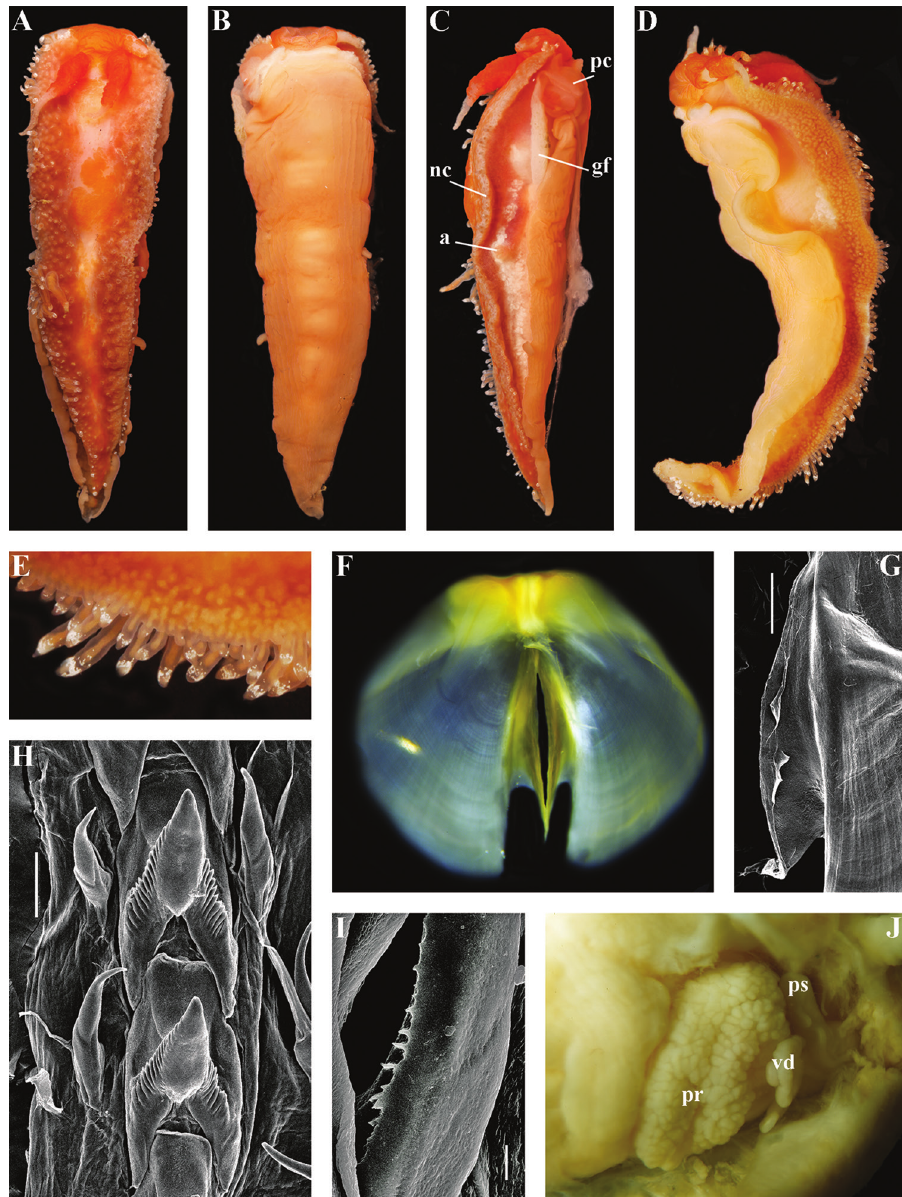
Figure 3. Chlamylla borealis borealis Bergh, 1899, stat.n. ZMMU Op-479. Kara Sea, living animal 46 mm in length: A dorsal view B ventral view C right lateral view D left lateral view E details of cerata and notal edge F jaws, frontal view, light microscopy G details of masticatory process of jaw, SEM H radular teeth, middle part, SEM I details of small denticles on lateral teeth, SEM J reproductive system, light microscopy. Abbreviations: a anus gf genital fold nc continuous notal edge pc penial collar (external) pr prostate ps penial sheath vd vas deferens (muscular part). Scale bars: G = 500 μm; H =100 μm; I = 10 μm. Photos of living specimens by O.L. Zimina, other photos and SEM images by A.V.